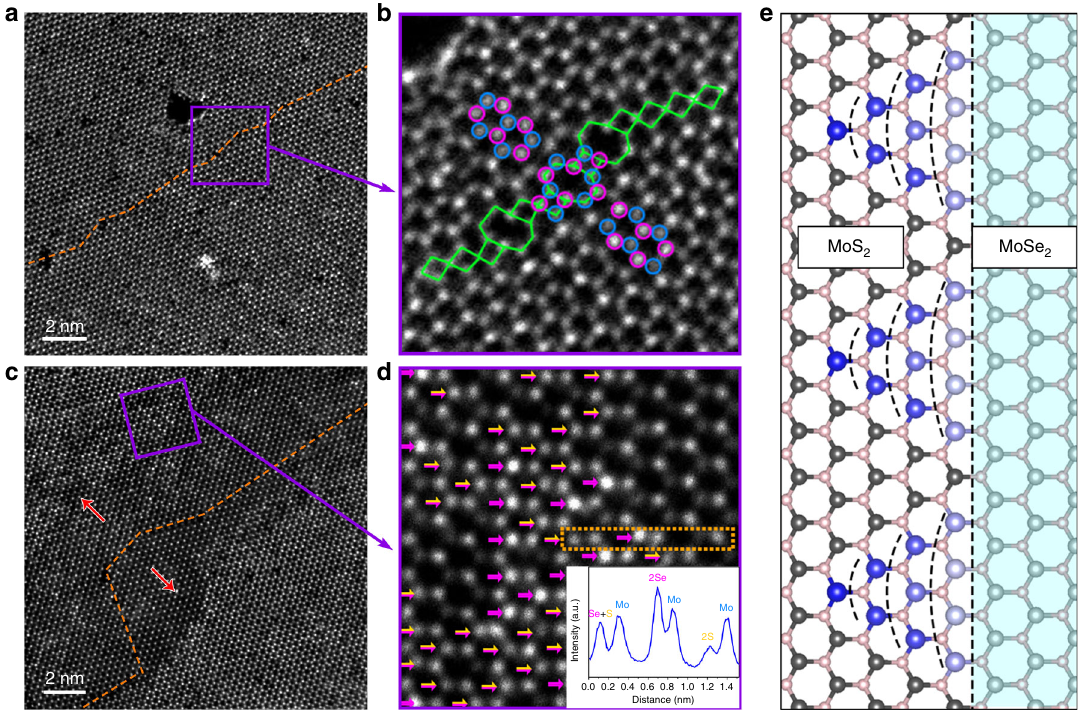
Fig. 6 Growth process of MoS 2 channels. a , b ADF-STEM images of intrinsic 60° GB (orange dashed line) within pristine monolayer MoSe 2 . Atomic arrangement of this GB (blue and purple circles: Mo and Se atoms; and green tetragons and octagons: 4 and 8 rings) resembles that in MoS 2 nano- channels. c , d ADF-STEM images showing part of MoSe 2 – MoS 2 hybrid winding channel. Some Se atoms has been replaced by S atoms, as indicated in d (purple arrows mark 2Se atoms and yellow – purple arrows mark S + Se atoms). Line intensity pro fi le of 2Se, 2S, S + Se, and Mo atoms is provided in the insert of d . The red arrows in c represent the sul fi dation direction. e A contour plot for the sequence (from blue to light gray) of substitution reaction along a zigzag MoSe 2 – MoS 2